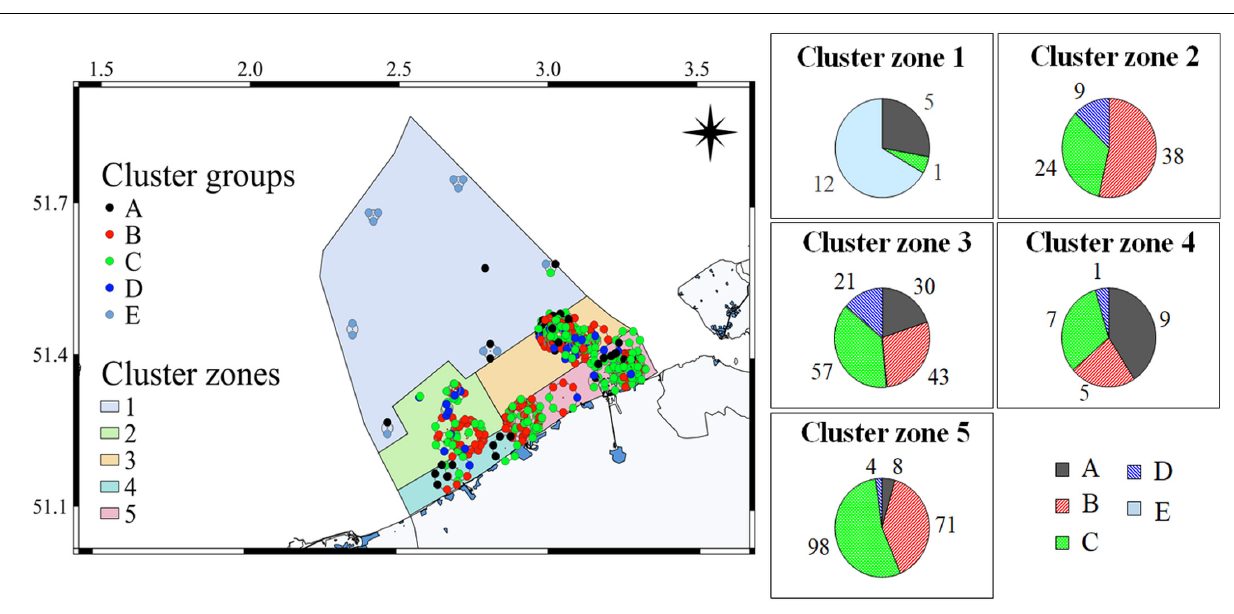
FIGURE 6 | Spatial zonation of the BPNS into five cluster zones, based on Ward hierarchical clustering (cluster groups), the PCA association patterns, and sedimentological characteristics. Numbers in the pie diagrams represent the number of samples/locations found in each cluster group per cluster